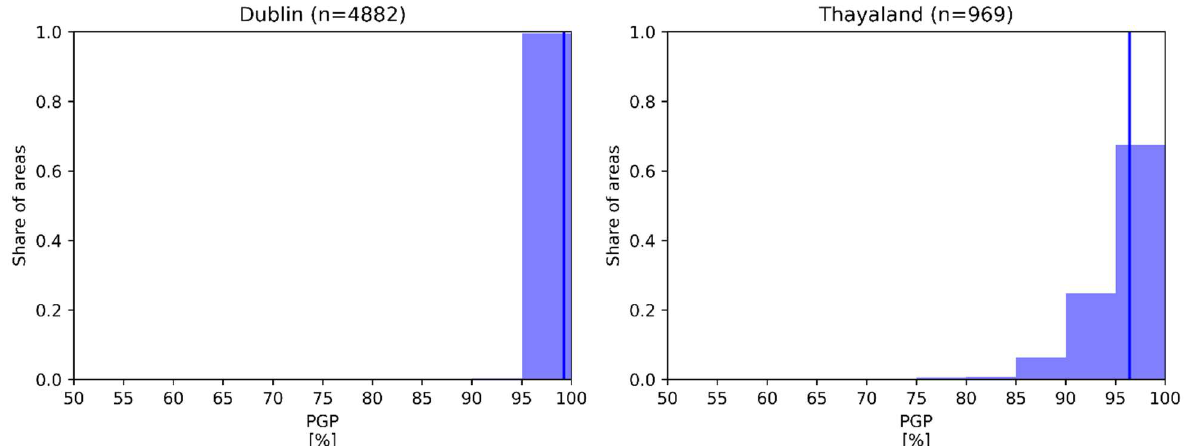
Figure 4. Distribution of the number of buildings per area ( top ) and the PGP score per area ( bottom ) for both cases. The vertical line indicates the median value. An area constitutes the spatial unit used to generate the spatial building stock (Small area in the case of Dublin, grid cell in the case of Tha- yaland).